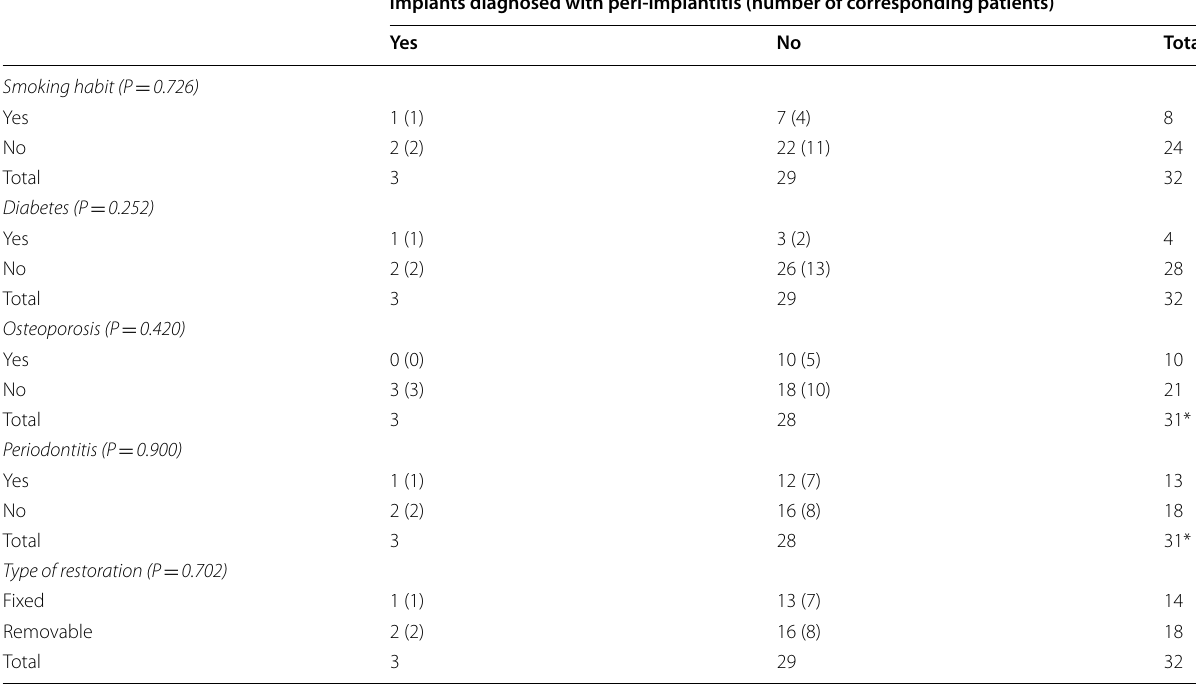
Due to the limited number of implants with peri-implantitis, no significant correlation could be shown * Medical history regarding osteoporosis and periodontitis was missing for one patient